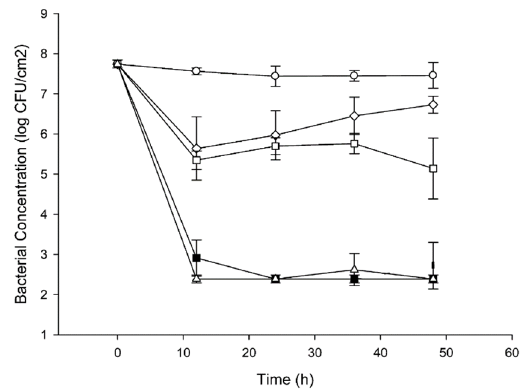
Figure 15. Viable counts in the challenge test on apple peels with L. monocytogenes versus silver nitrate aqueous solution (black square), EVOH (circle), and EVOH composite films with 0.1 wt% Ag + (diamond), 1 wt% Ag + (square), and 10 wt% Ag + (triangle). Reproduced from [175] with permission of the American Chemical Society.